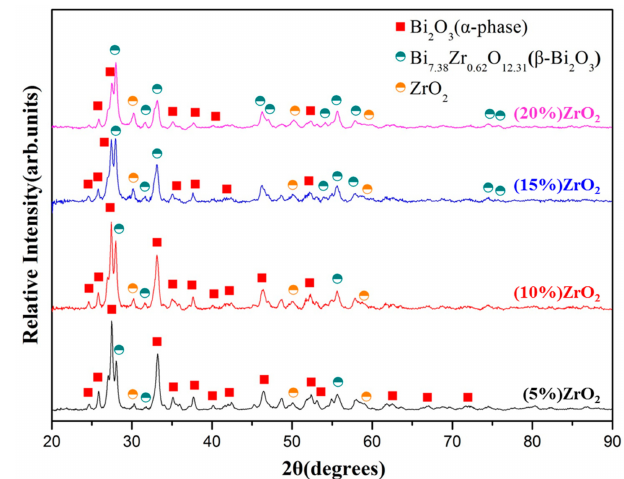
Figure 4. X-ray di ff raction patterns of bismuth oxide and zirconia powder mixtures after 30 min of ball milling treatment.